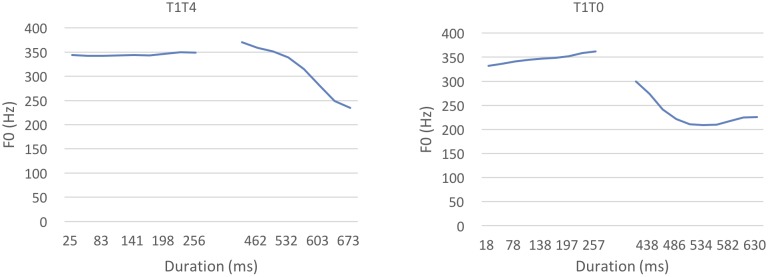
Average F0 contours of T1T4 and T1T0.